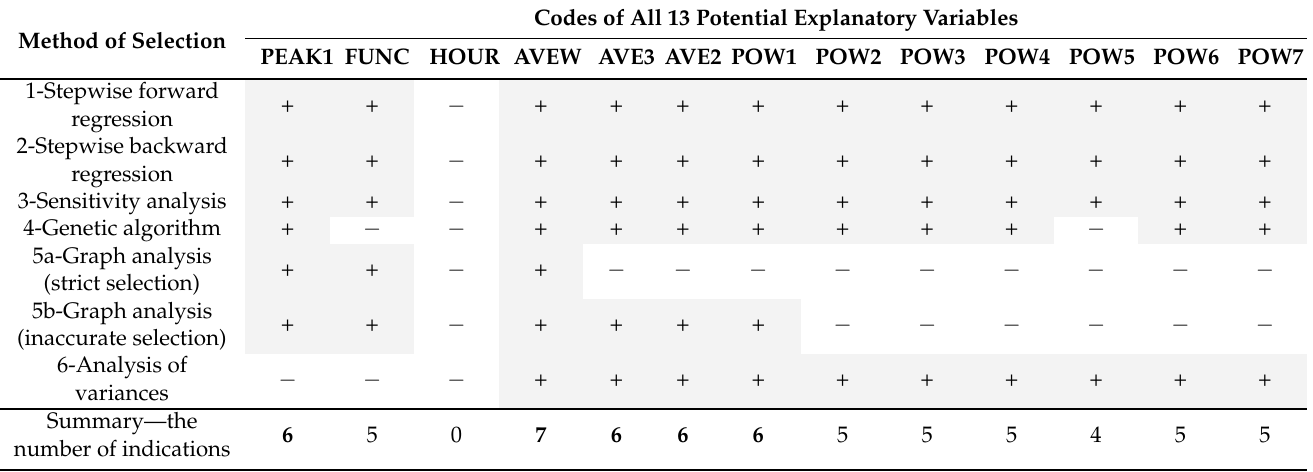
Table 3. Results of initial selection of explanatory variables for all 6 methods of selection—selection for time series No. 1. Method of Selection